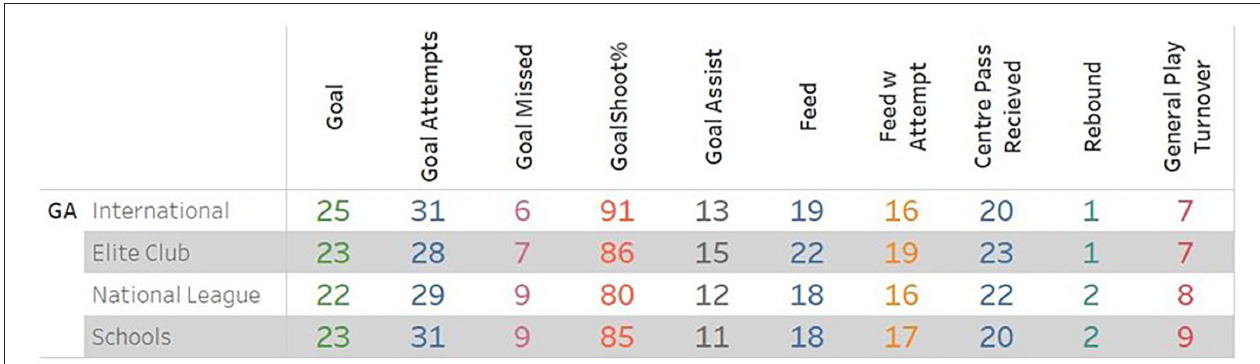
FIGURE 6 | Example of coaches normative table showing 75th percentile values for values for performance indicators. percentile boundaries. Although not distinctly measurable, there appears to be an overall visual trend for general play turnovers (GPT) to increase as performance went down the levels, i.e., from international down to